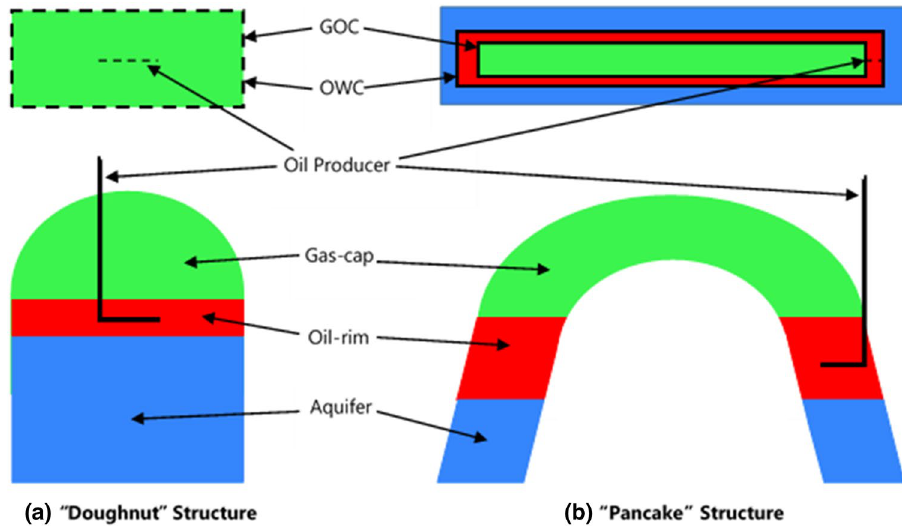
Fig. 1 Configurations of oil-rim reservoirs in plan and cross section, where GOC and OWC are the gas–oil contact and oil–water contact, respectively (Lawal et al.